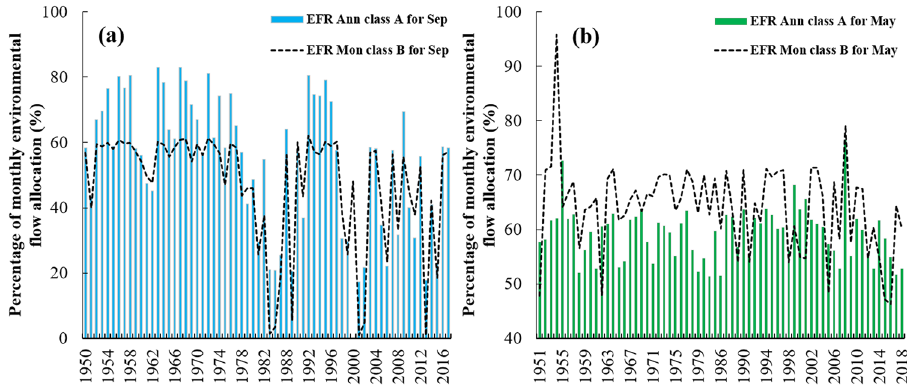
Figure 7. Percentage of monthly environmental flow allocation relative to the natural flow capacity with the comparison of the EMC-A of the annual method with the EMC-B of the monthly method at the Tapik Station, Nazlu River: ( a ) September and ( b ) May.